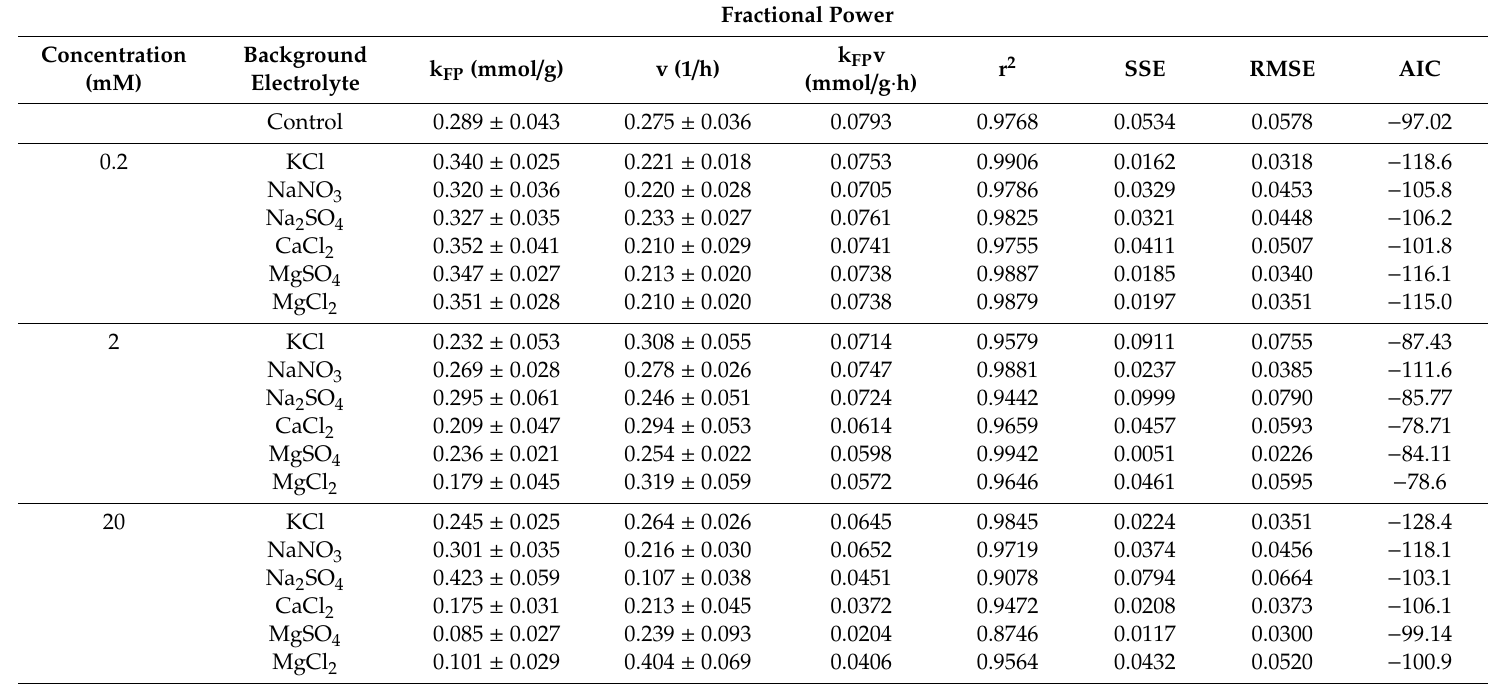
Table 6. Parameters of the fractional power model for the biosorption of Ni 2 + by QCS at 0.2, 2, and 20 mM of background electrolytes. Fractional